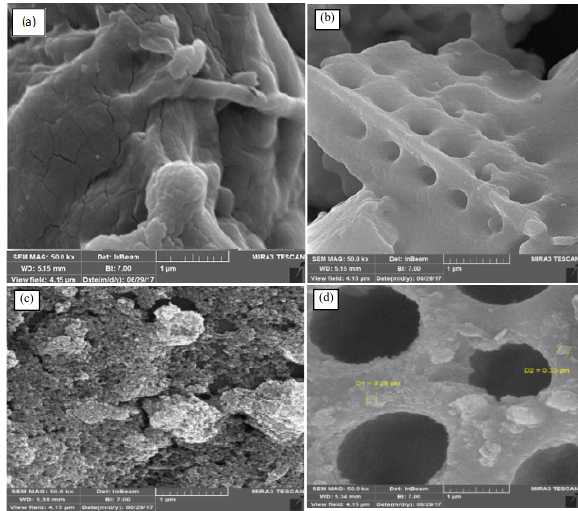
Fig. 1. SEM images of the (a) sodiumalginate, (b) biosilica, (c) magnetic, (d) MBAS